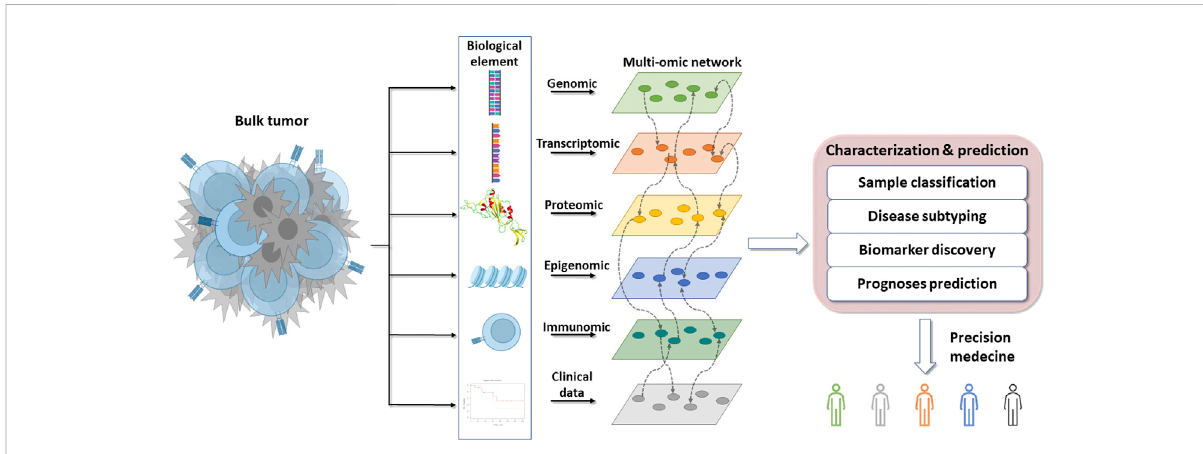
FIGURE 1 Over fl ow of the omics integration for precision medicine. The bulk tumor is composed of many different biological elements that can be classi fi ed and used to fi nd novel interactions between interconnected elements. These interactions can be used to molecularly characterize and subtype cancers with the aim of anticipating their clinical evolution and treatment sensitivity to promote precision